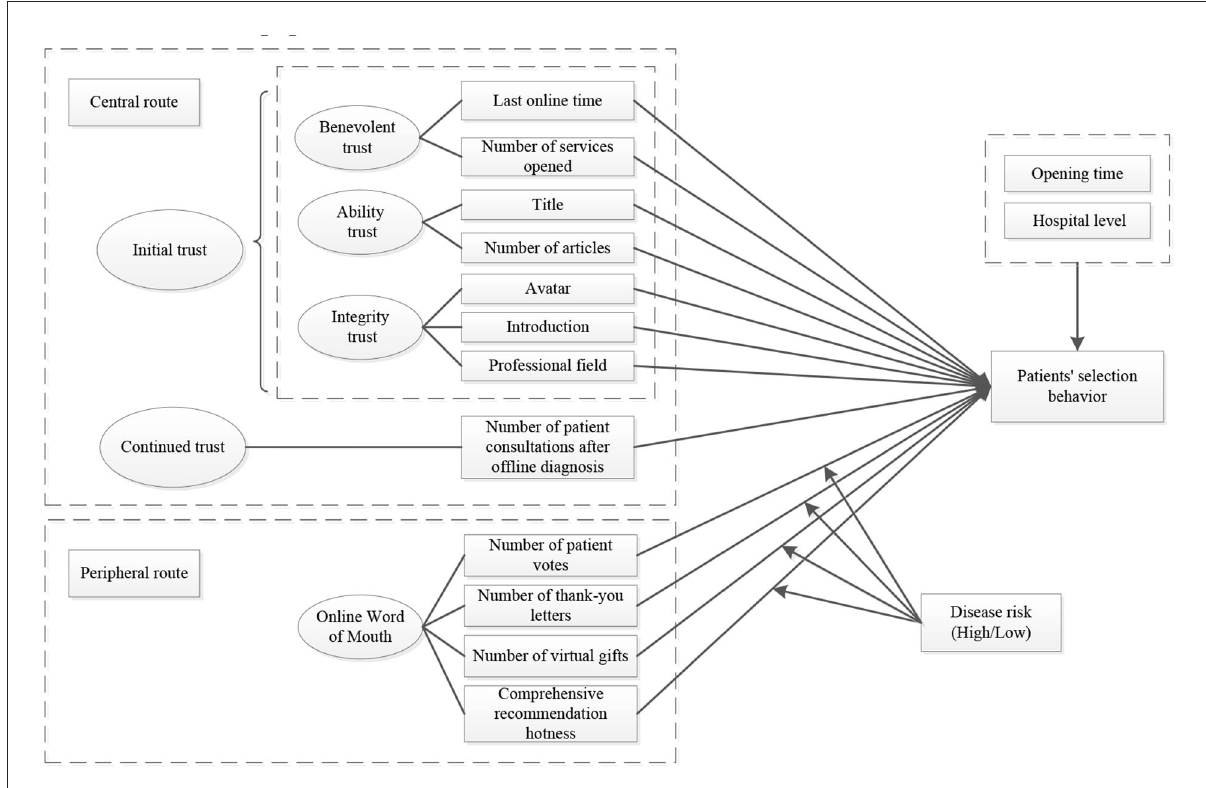
FIGURE1 Conceptual model of patients’ selection behavior in